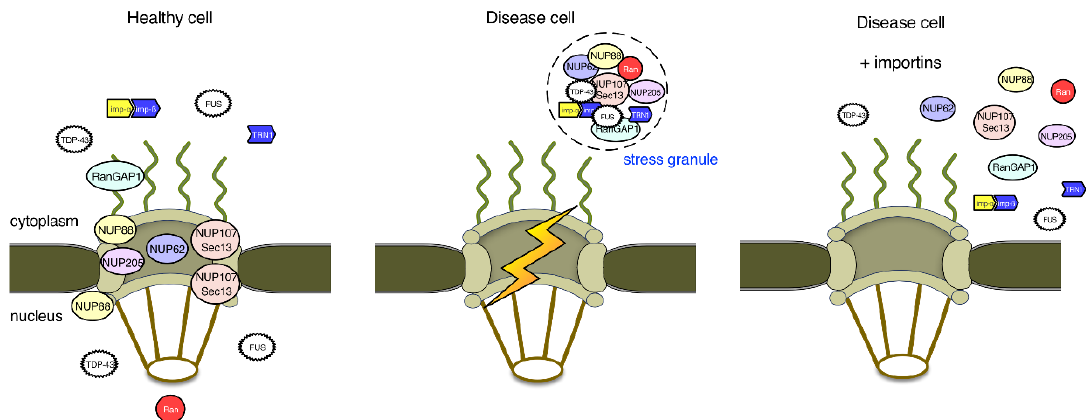
Figure 4. Nuclear pore proteins and nuclear import in ALS and FTD. In healthy cells, the RNA-binding proteins TDP-43 and FUS are localized to both the nucleus and the cytoplasm. In disease cells, nuclear import of TDP-43 and FUS is impaired, which leads to their aggregation into stress granules (SGs) in the cytoplasm. TDP-43 and FUS in SGs sequester several nucleoporins and factors important for the regulation of nucleocytoplasmic transport, establishing a vicious cycle. Although overexpression of importins, such as importin- β and transportin-1, may cause the dissolution of TDP-43 and FUS aggregates, whether the nucleocytoplasmic transport machinery is restored to normal function remains to be